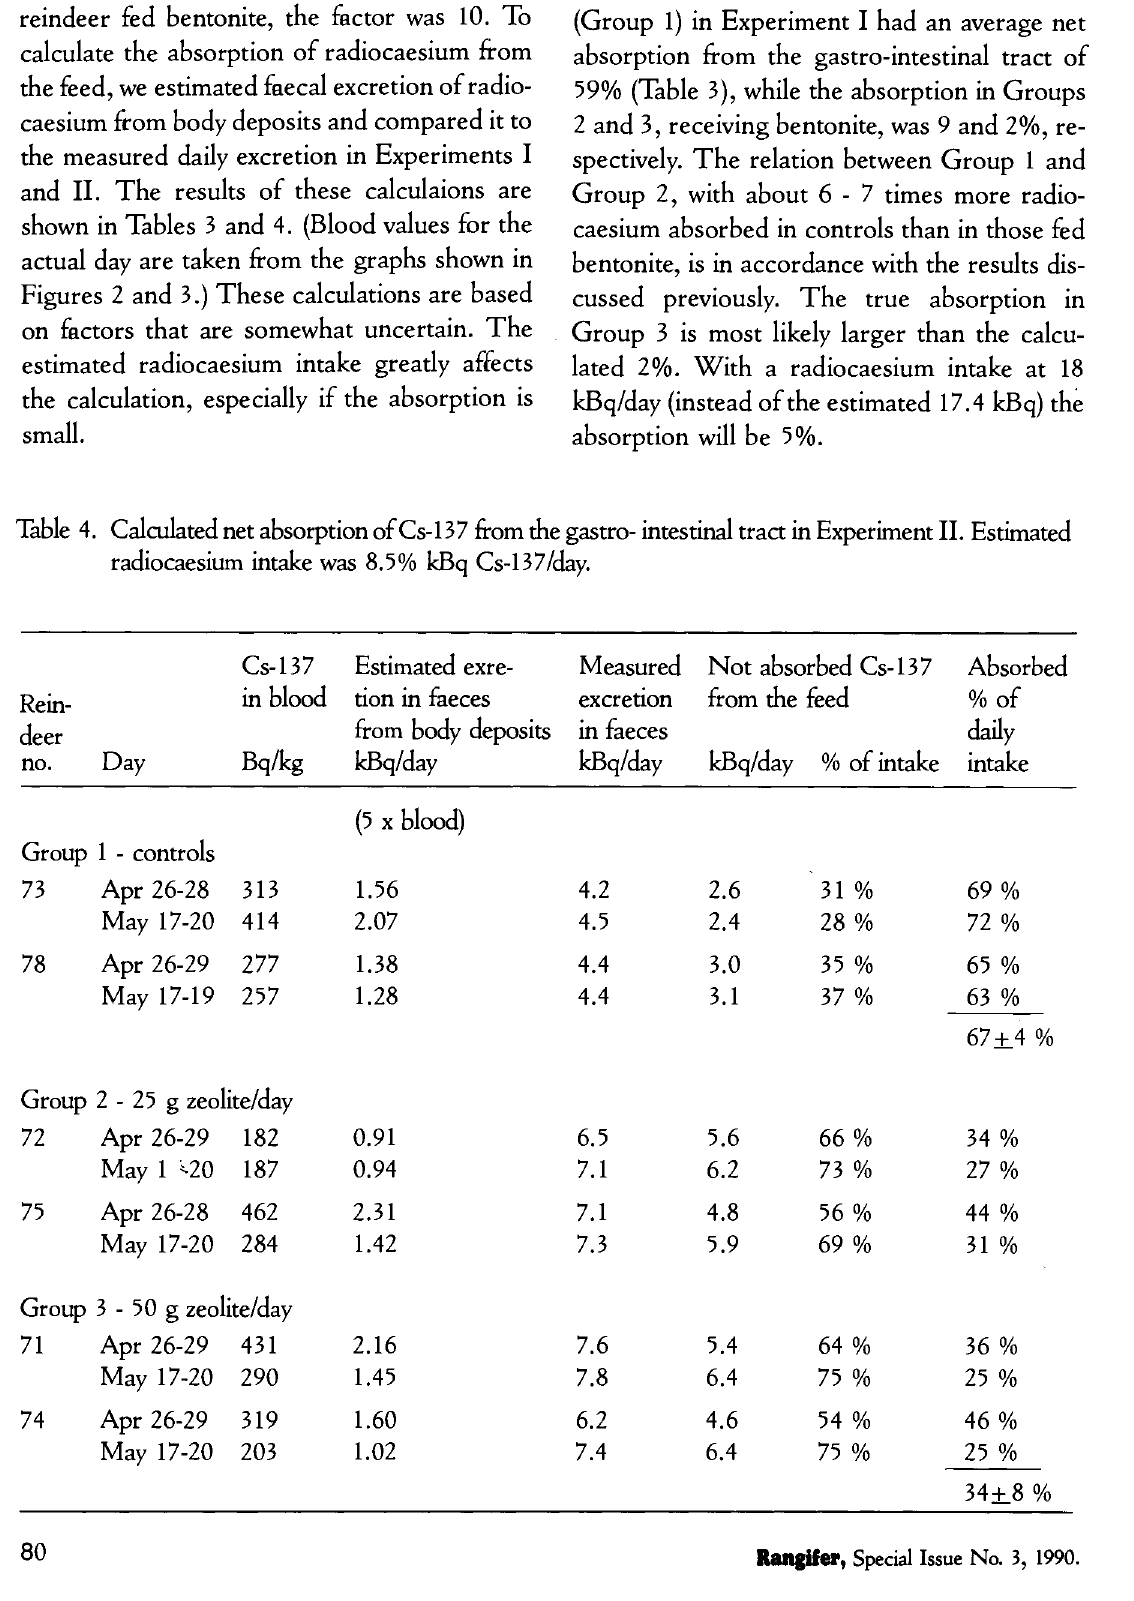
Table 4. Calculated net absorption of Cs-137 from the gastro- intestinal tract in Experiment II. Estimated radiocaesium intake was 8.5% kBq